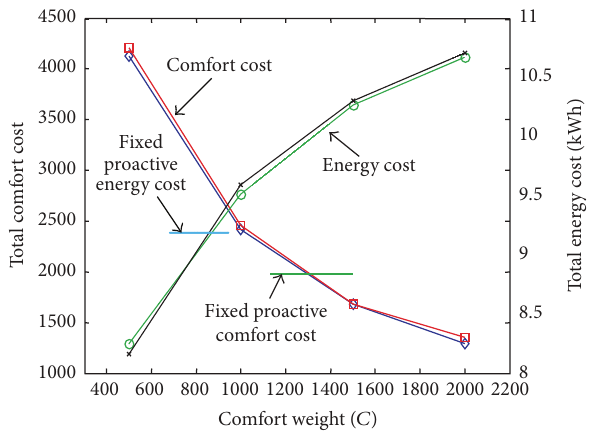
Figure 15: Total energy and comfort costs (cascade movement sce- nario).